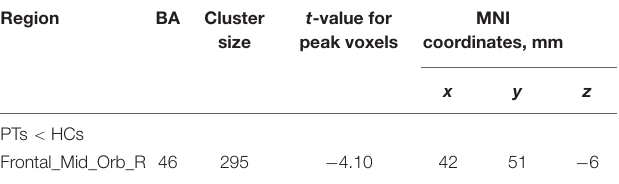
TABLE 3 | Brain regions showing significant fALFF differences between CAI patients and HCs. Region BA Cluster size